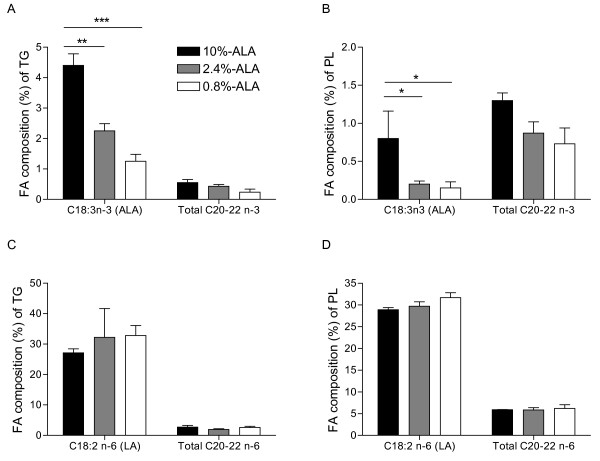
Fatty acid composition (mol %) of plasma triglycerides (TG) and phospholipids (PL) at d21. Proportion of ALA and total other long-chain n-3 PUFAs (C20:3n-3, C20:5n-3, C22:5n-3, C22:6n-3) in plasma TG (A) and PL (B). Proportion of LA and total other long-chain n-6 PUFAs (C20:2n-6, C20:3n-6, C20:4n-6, C22:2n-6, C22:4n-6) in plasma TG (C) and PL (D). Data are medians ± SEmedian, n = 4-5 samples/group in duplicate. LA, linoleic acid; ALA, alpha-linolenic acid. * p < 0.05, ** p < 0.01, *** p < 0.001 between groups.